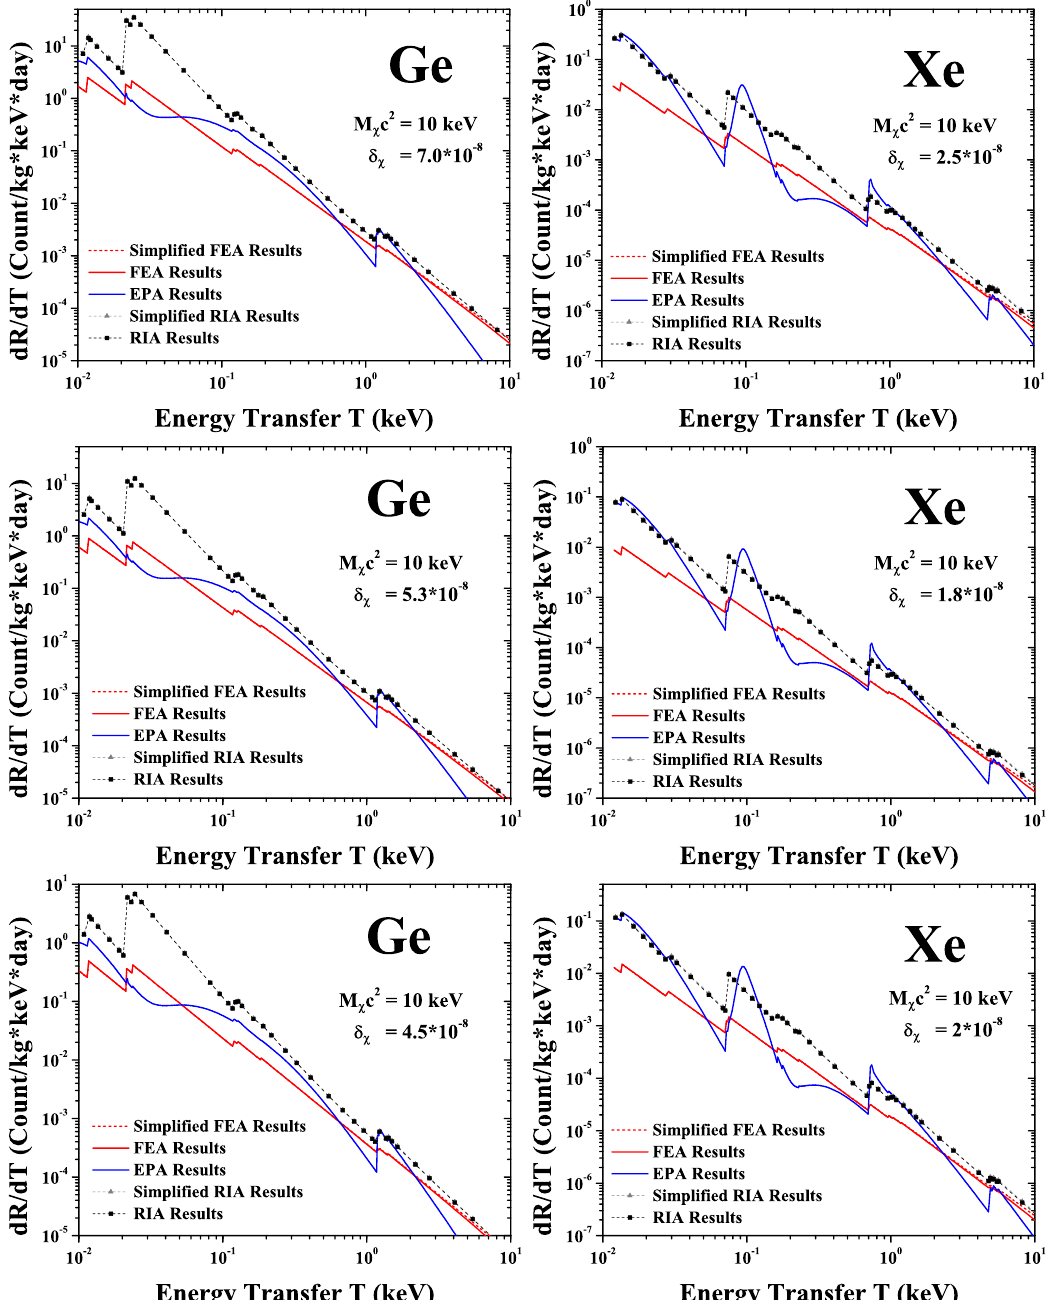
Figure 13 . The differential reaction event rates for the atomic ionization process induced by millicharged particles in HPGe and LXe detectors. The mass of millicharged dark matter particle is set as m is chosen such that the reaction event rates in HPGe 2 = 10 keV, and its millicharge δ χ c χ and LXe detectors match the experimental background levels for next-generation experiments, respectively. In this figure, the horizontal axis represents the energy transfer T , and the vertical axis represents the differential event rate dR/dT in unit of cpkkd. The same as in figure 6 and figure 9, the red solid lines correspond to the FEA results; red dashed lines represent the simplified FEA results; blue lines stand for the EPA results; black squares display the RIA results; gray triangles show the simplified RIA